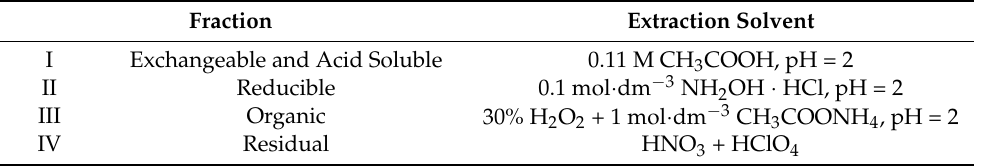
Table 1. Scheme of the sequential analysis of metals according to BCR. Fraction Extraction